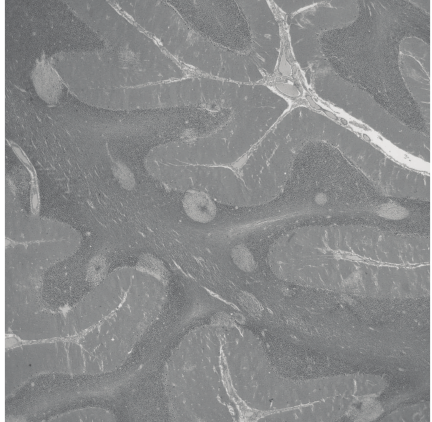
Figure 3: The pale ovals in the cerebellum were typical of the ede- matous foci throughout the central nervous system. There was often a small vessel in the center of the edema (2x original magnification, H&E